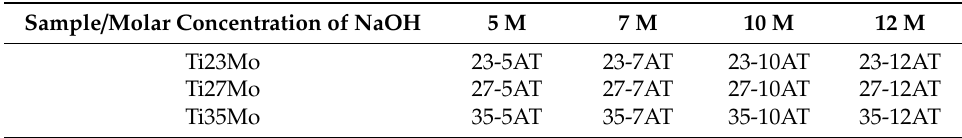
Table 1. Sample indication after alkaline treatment.